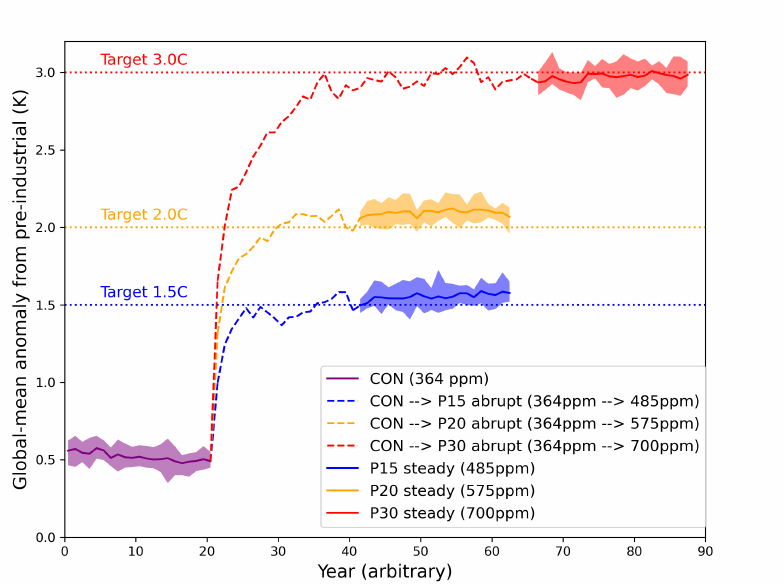
Figure 1. Global-mean near-surface (1.5 m) air temperatures (K) expressed as anomalies relative to the pre-industrial period (1851–1900 in HadCRUT4.4). The solid lines show the ensemble-mean for each of the four ten-member ensemble experiments: CON (purple), P15 (blue), P20 (orange) and P30 (red). For these lines, the shading shows the range between the maximum and minimum of the ten-member ensemble. The dashed lines show the abrupt-CO 2 simulations that were used to spin-up from the end of CON to the beginning of P15, P20 and P30, in the same colours. The dotted lines show the target warming levels for each experiment, also in the same colours. The respective CO 2 forcings are provided in the